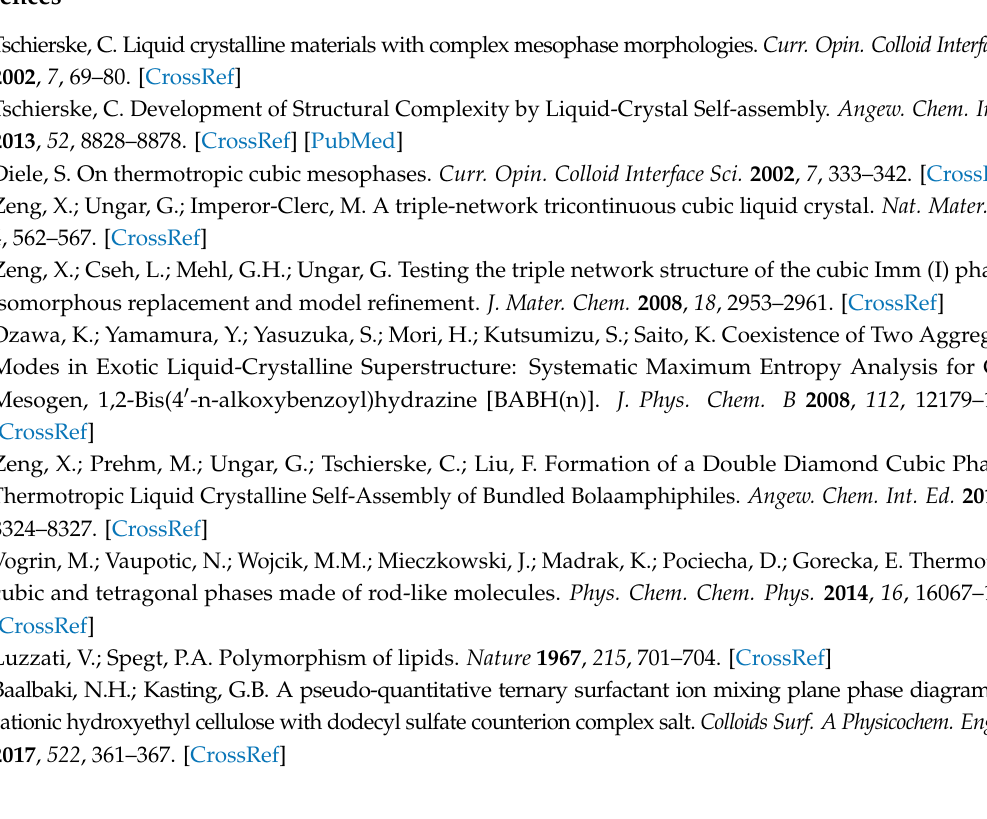
Figure S1: Fitting of the magnetization trends recorded for L1 sample at 396K at high field ( a ) and at low field ( b ), by using a single- and two-exponential